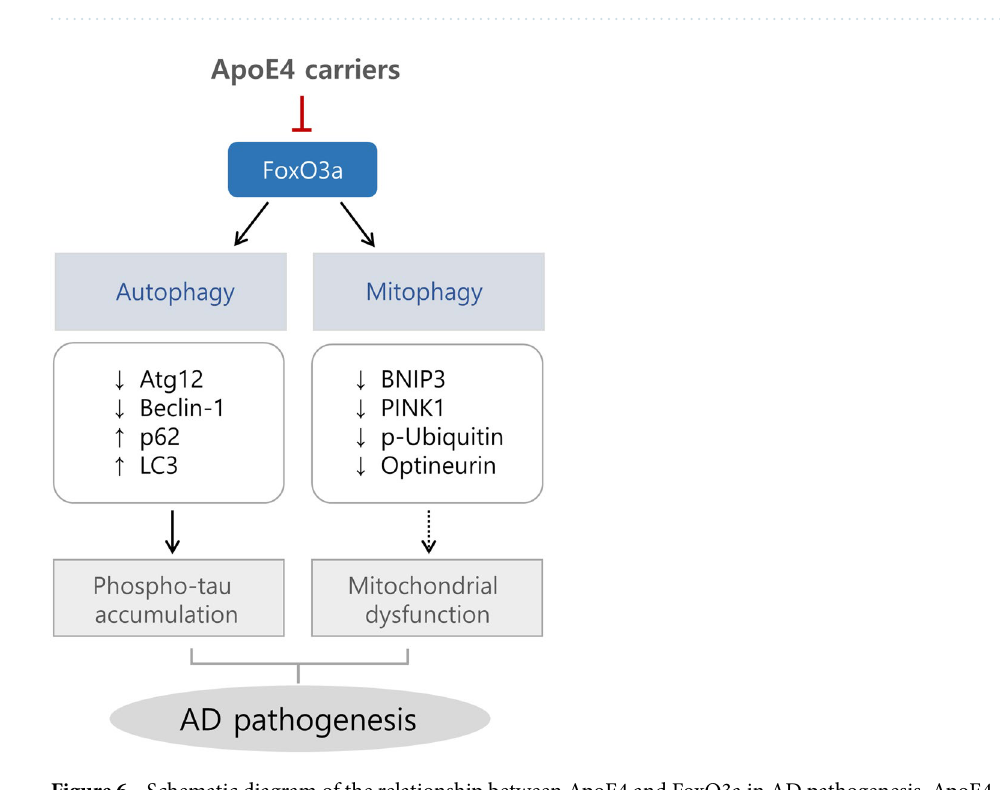
Figure 6. Schematic diagram of the relationship between ApoE4 and FoxO3a in AD pathogenesis. ApoE4 represses the transcription factor FoxO3a. Downregulation of FoxO3a reduces the protein levels of its autophagy/mitophagy-related downstream genes, such as Atg12, Beclin-1, BNIP3, and PINK1, which could result in an impairment of autophagy and mitophagy. Dysfunction of autophagy might increase the levels of phosphorylated tau proteins, leading to AD